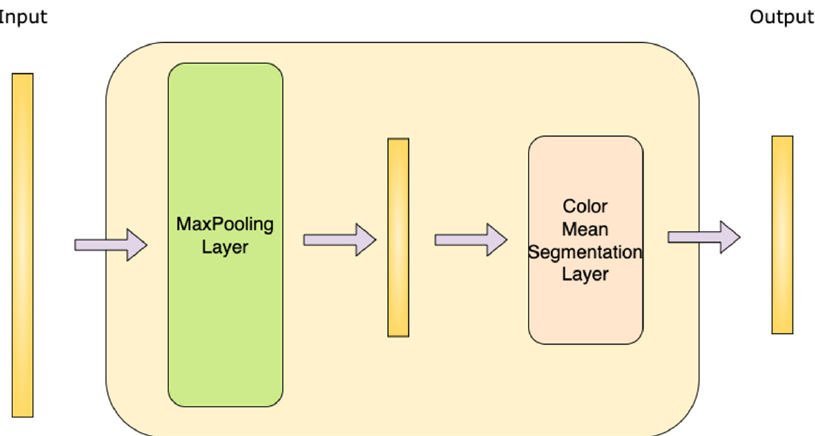
Figure 2. Structure of single unit of CMS-Encoder.